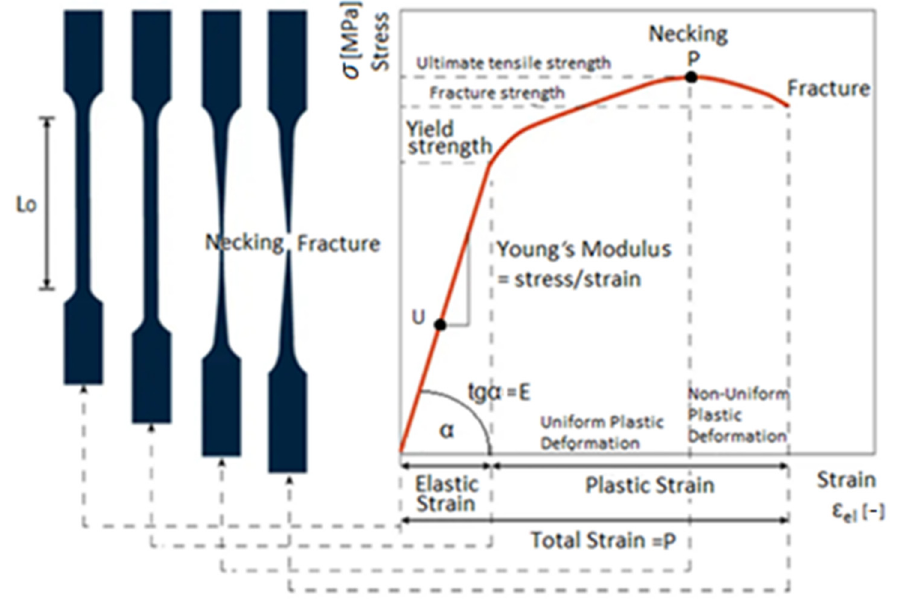
Figure 2. Elongation of the test sample depending on the force applied to the sample [2].